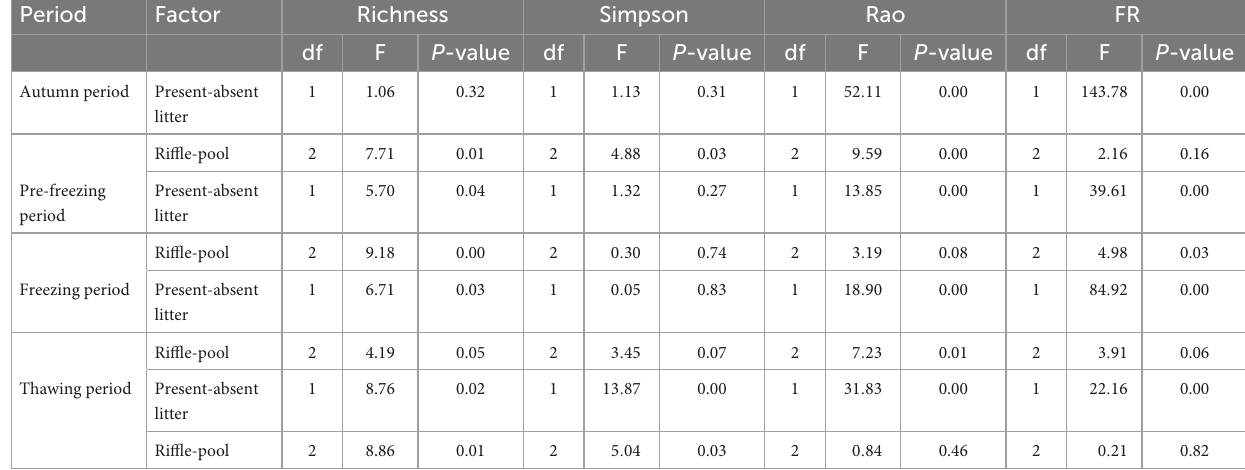
TABLE 1 Nested analysis of variance (ANOVA) for present-absent litter and habitat (riffle-pool) effects on richness, Simpson, Rao, and functional redundancy (FR) in each